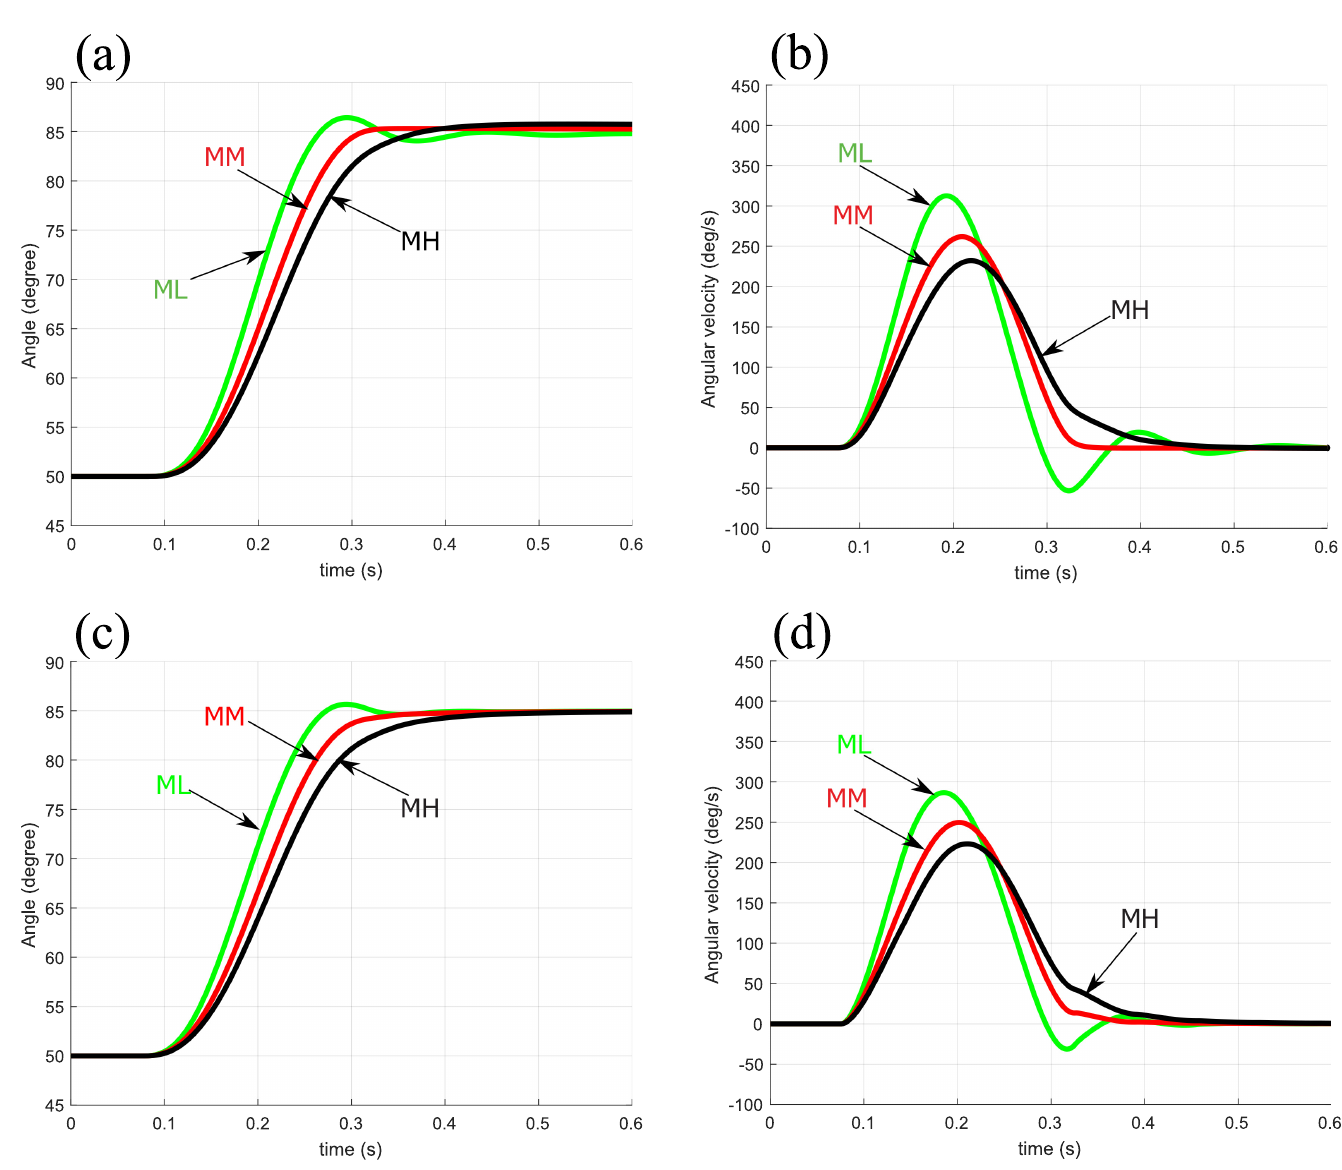
Fig 9. Simulated movements. The position and velocity are exhibited on the left and right panels, respectively, under unexpected inertial load changes with the optimal control (a, b) and the proposed control (c, d). ML stands for the inertial change from the intermediate load to the low load; MH from the intermediate load to the high load. MM indicates no change from the intermediate load. The output of the proposed model converges to the target position regardless of inertial loads presented, whereas the optimal model does not; the end-point errors of the optimal model are notably higher than those of the proposed model. Since the proposed model eliminates the system dynamics and injects planned dynamics, it is reasonable to expect the system simulated by the proposed control converges to a desired